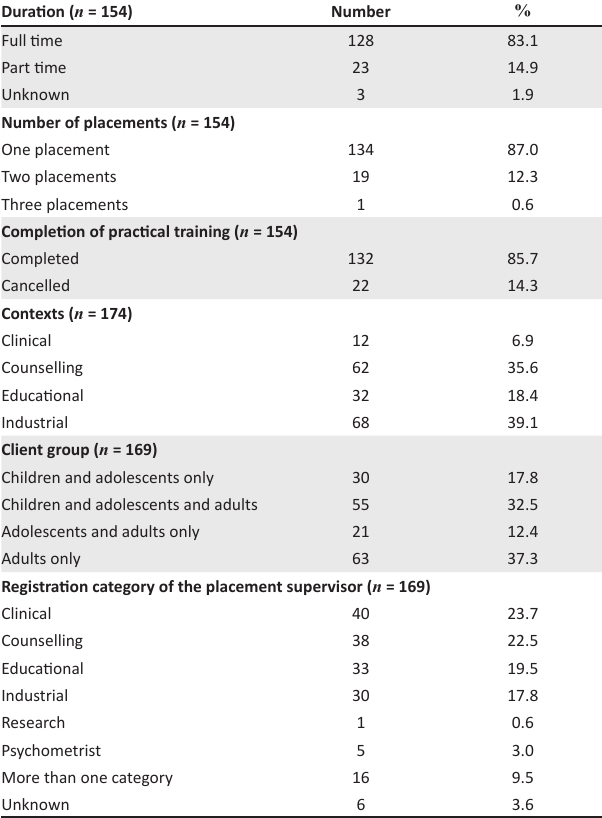
TABLE 2: Practical training and placement contexts of the Unisa student psychometrists. Duration ( n = 154)